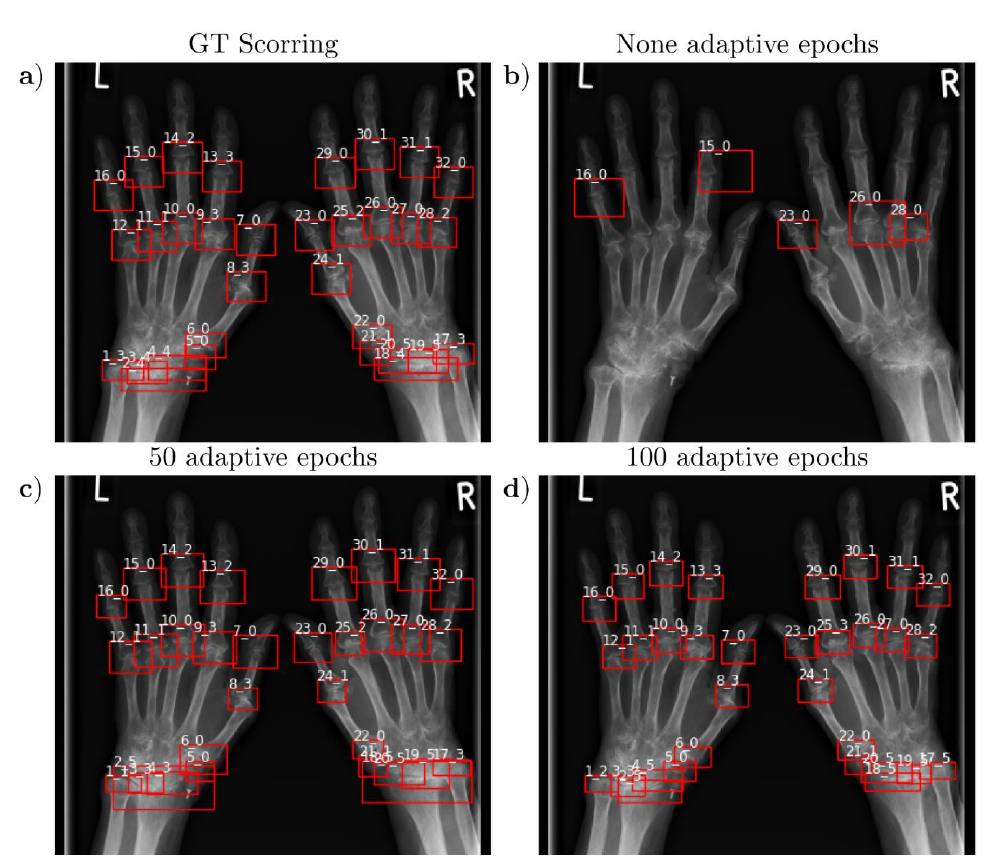
Figure 4. Visualization of a representative hand of a 68-year-old female patient and SvH erosion classifications for the best-trained models according to the mAP metric of the validation patients as a function of adaptive epochs and the corresponding manual reference classifications from an experienced rheumatologist. ( a ) Reference ground truth (GT) image from an experienced rheumatol- ogist. ( b ) Without adaptive adjustment of IoU values during training, not all joints were localized, and the network mainly classified joints with an erosion value of 0, regardless of joint degeneration. Retinal networks trained with adaptive adaptation over 50 epochs and IoU pos \ neg 0.4 \ 0.3 values ( c ) or 100 epochs and IoU pos \ neg 0.5 \ 0.3 values ( d ) recognized all joints. Strikingly, adaptation over 100 epochs provided slightly higher localization accuracy and outperformed GT localization accuracy. In contrast, in the model fitted over 50 epochs, all erosion classifications matched the reference image, whereas the model held over 100 adaptive epochs misclassified two